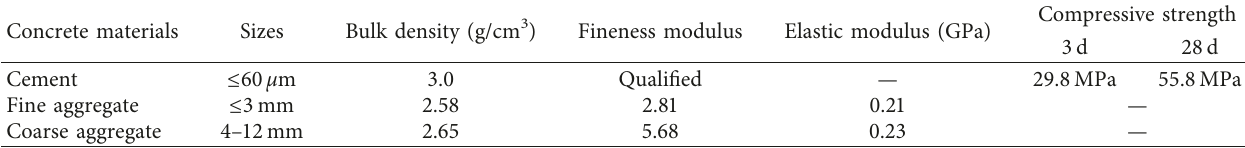
Table 6: Physical properties of concrete materials.